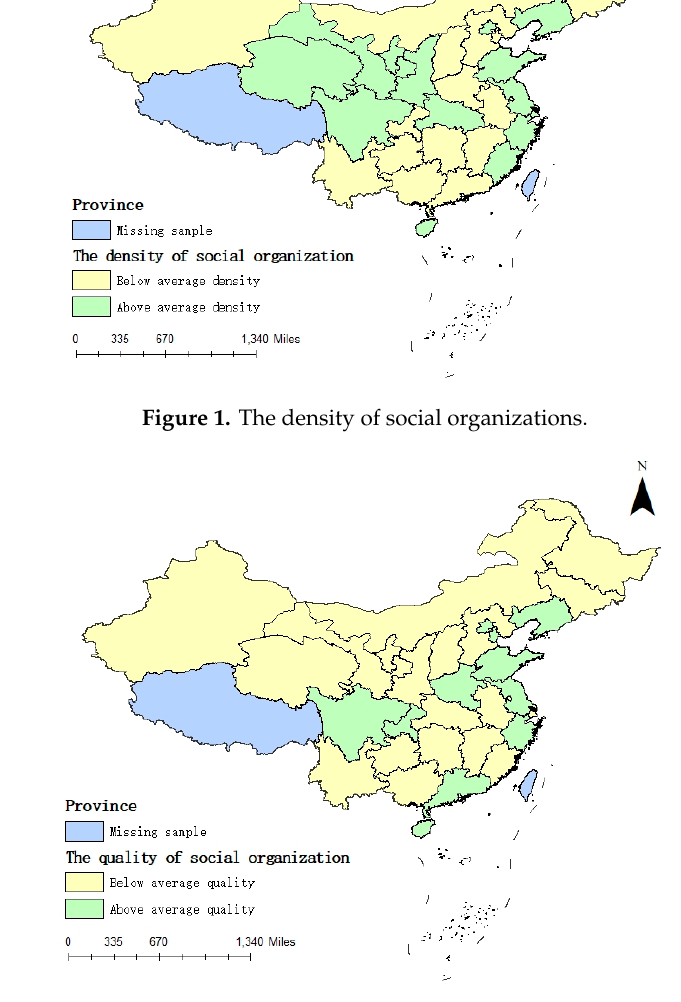
Figure 2. The quality of social organizations.